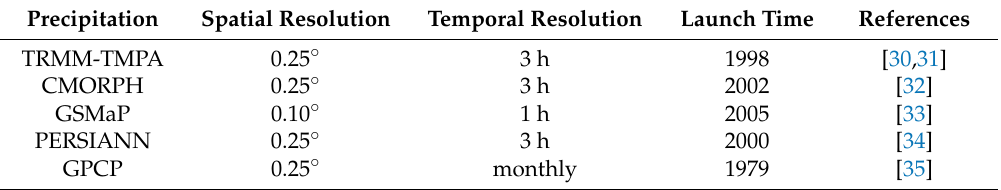
Table 1. A summary of primary global satellite precipitation